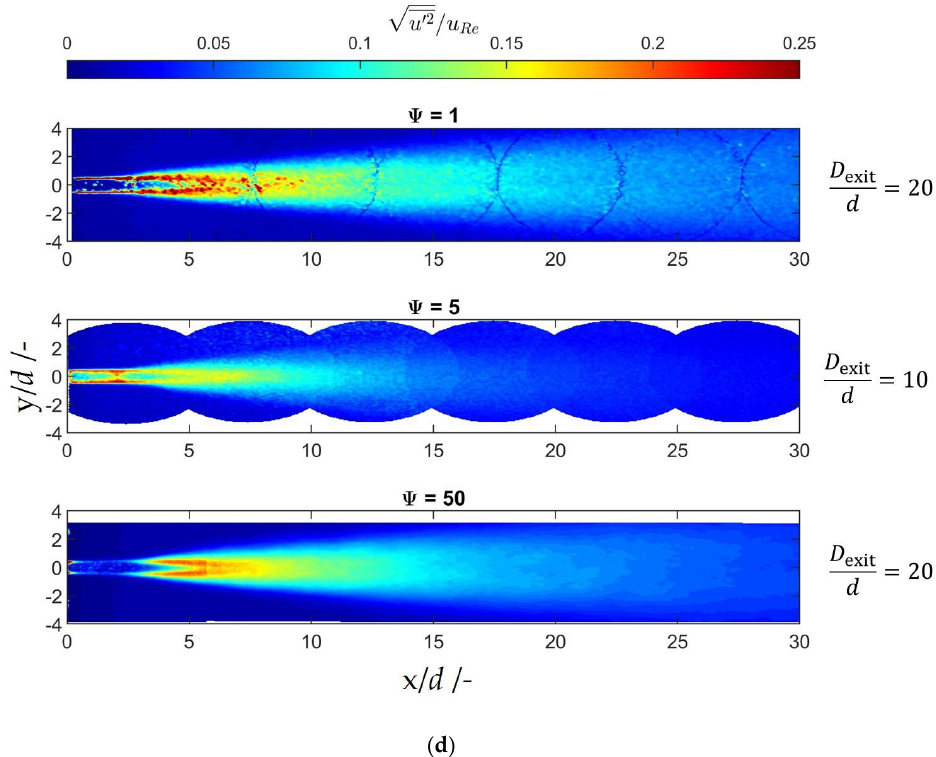
Figure 5. ( a ) Normalized velocity fields of all three scales at Re = 2000; ( b ) normalized velocity fluctuation of all three scales at Re = 2000; ( c ) normalized velocity fields of all three scales at Re = 5700; ( d ) normalized velocity fluctuation of all three scales at Re = 5700. Due to the limited working distance of the microscope, it was not possible to conduct measurements within the 5-fold scaled system for any diameter ratios 𝐷 exit 𝑑⁄ larger than 10.